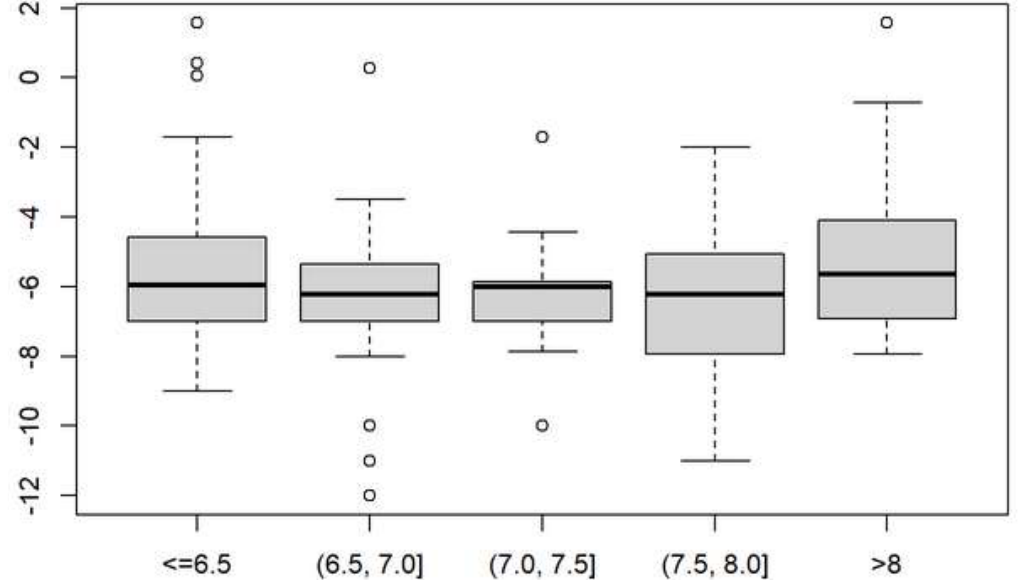
Figure 1. Difference in the lowest number of capillary blood glucose readings per day between the different capillary glycated hemoglobin groups one year after sensor insertion.